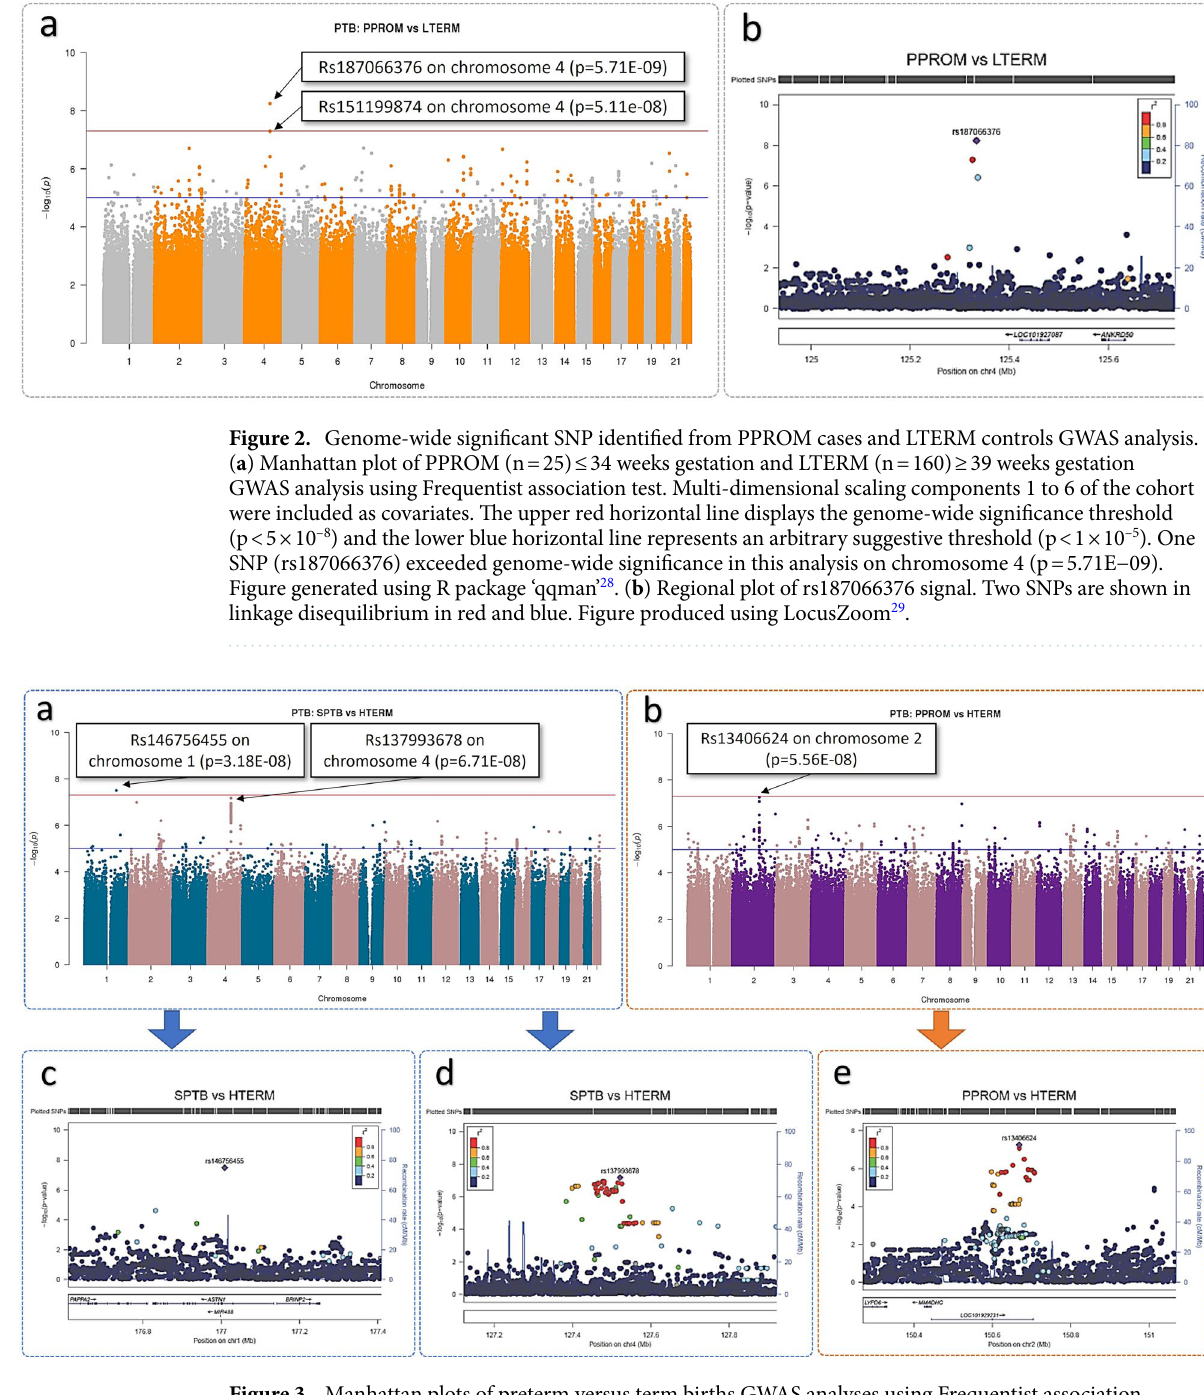
Figure 3. Manhattan plots of preterm versus term births GWAS analyses using Frequentist association test. ( a ) SPTB (n = 23) ≤ 34 weeks gestation and HTERM (n = 102) ≥ 37 weeks gestation and ( b ) PPROM (n = 25) ≤ 34 weeks gestation and HTERM (n = 102) ≥ 37 weeks gestation. Multi-dimensional scaling components 1 to 6 of the cohort were included as covariates. The upper red horizontal line displays the genome-wide significance threshold (p < 5 × 10 –8 ) and the lower blue horizontal line represents an arbitrary suggestive threshold (p < 1 × 10 –5 ). Manhattan plots were generated using R package ‘qqman’ 28 . Regional plots: ( c ) genome-wide significant SNP (rs146756455) on chromosome 1 was identified as an intron variant in the gene, ASTN1 (p = 3.18E−08) (SPTB versus HTERM); ( d ) rs137993678 approaching genome-wide significance on chromosome 4 (p = 6.71E−08) (SPTB versus HTERM). Several SNPs are in linkage disequilibrium; ( e ) rs13406624 on chromosome 2 was identified as a non-coding region, LINC01931 (or MMADHC-DT) (p = 5.56E−08) (PPROM versus HTERM). Regional plots were produced using LocusZoom 29